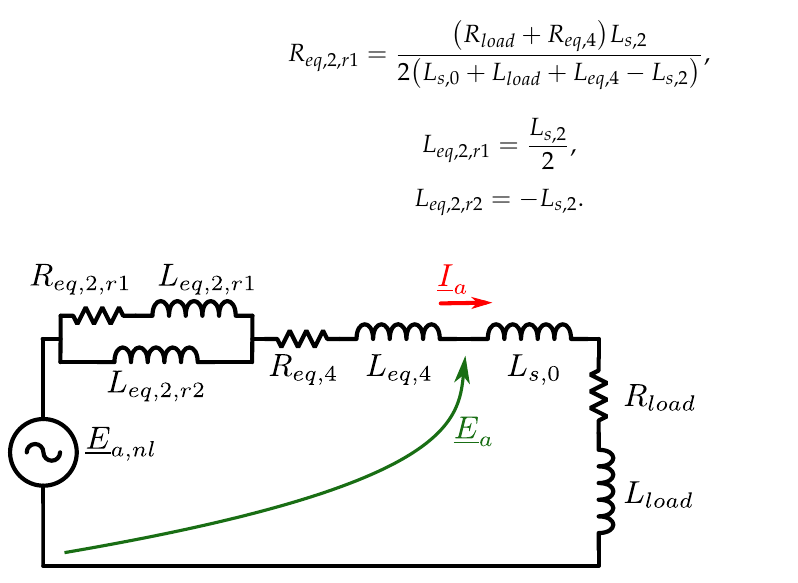
Figure 4. Per-phase FSM equivalent